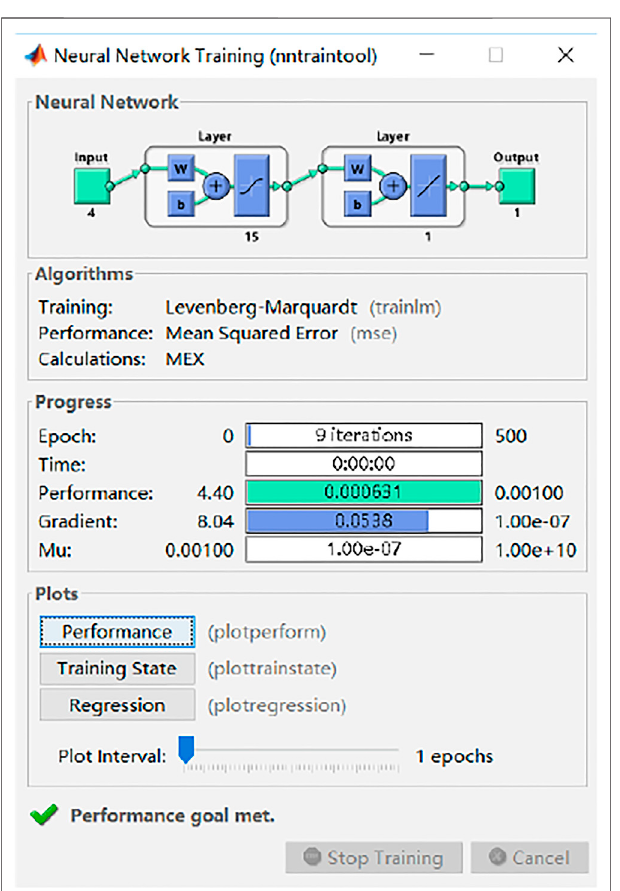
FIGURE 5 | CSO BP neural network simulation training